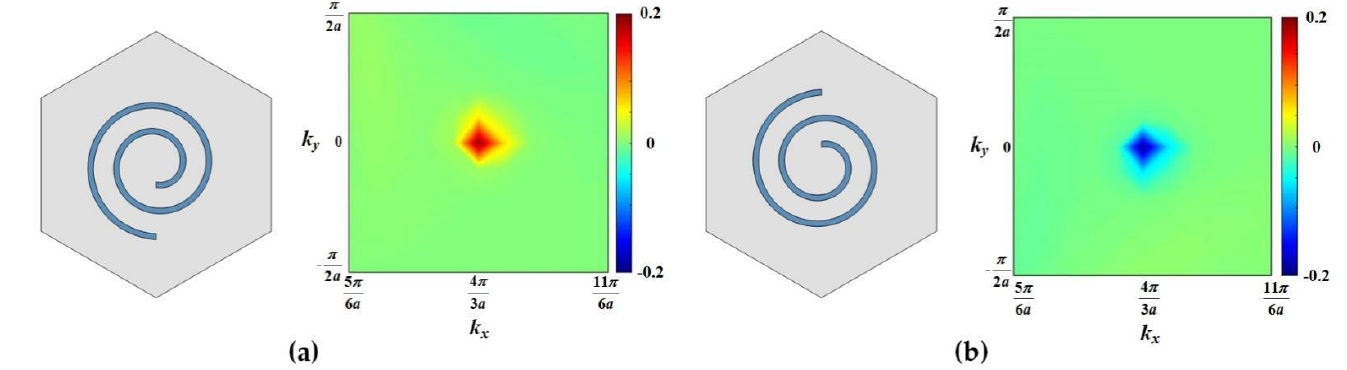
5  11  to and 6 a 6 a